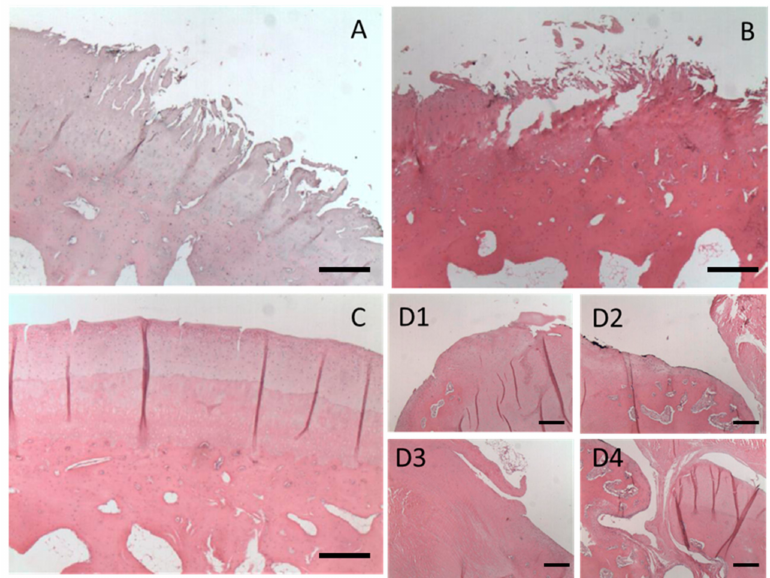
Figure 7. Representative histopathology of femur, Group C, 40 × . ( A ) Right femur, 6 months: a focal region of marked fibrillations of the articular cartilage is observed. ( B ) Left femur, 6 months: an extensive focal region of articular cartilage erosion is observed, exposing the subchondral bone and numerous fibrillations and fissures at the edges of the said region. ( C ) Right femur, 12 months: numerous fissures are observed in the hyaline cartilage, which is clearly eroded in its articular surface. The underlying bone presents mild thickening in its architecture (bone remodeling). ( D1 – D4 ) Four independent images of the same left femur, 12 months: exuberant lesion, with extensive focal loss of articular cartilage. The components of an old repair of a bone fracture are observed. Greater proliferation of fibrocartilage, bone, and newly formed vessels towards the depth of the femur. Complete loss of the architecture of the articular surface, with marked perivascular fibrosis, covering the joint face of the formed callus. Scale bar: 500 µ